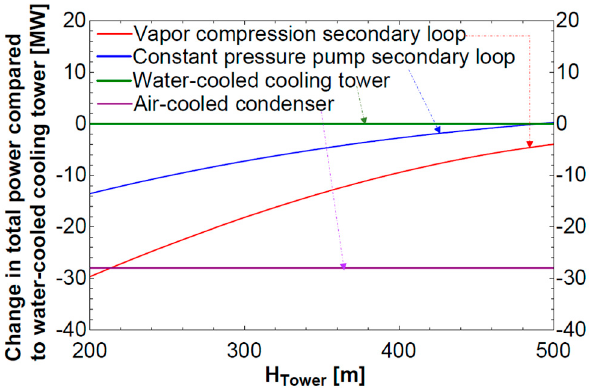
Figure 15. Change in total power of constant- pressure pump loop, vapor compression loop, and air-cooled condenser compared against a water-cooled cooling tower.